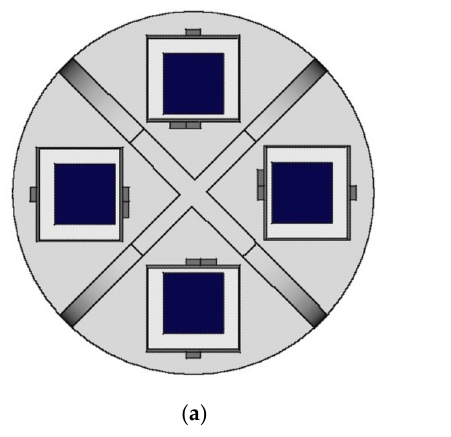
Figure 5. Sensors block scheme. ( a ) Design phase; and ( b ) built prototype.